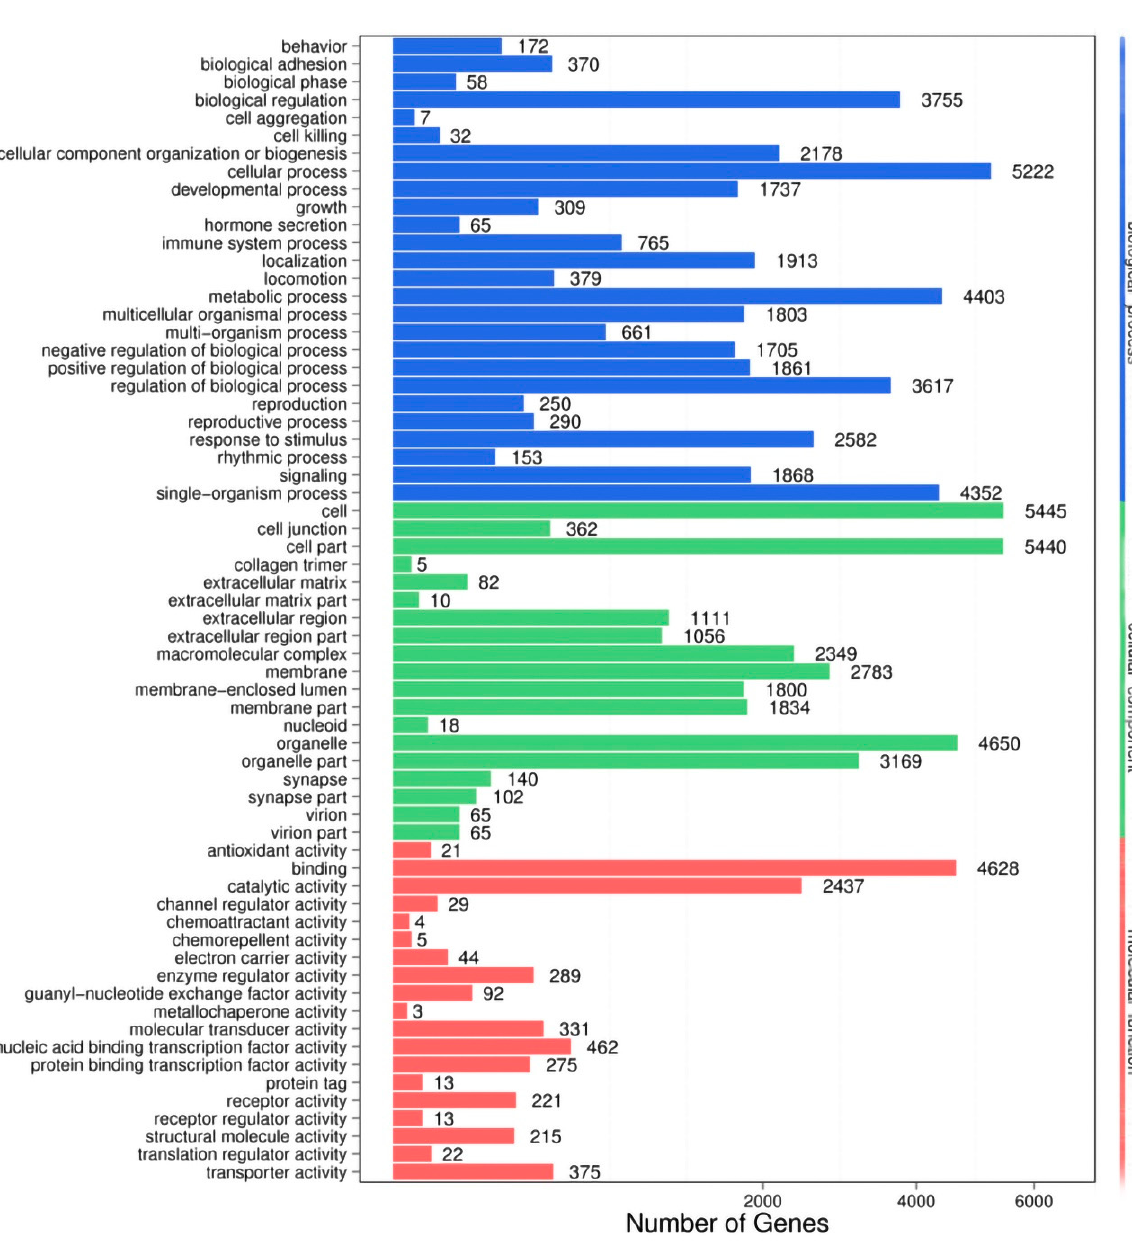
Figure 1. GO enrichment within the assembled transcriptome. The number of each bar indicates the number of genes in a category. The vertical axis shows identified GO terms. The right margin indicates the three groups of GO-enriched terms.